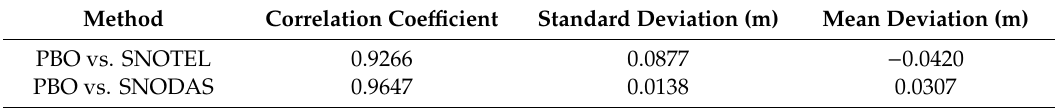
Table 3. Comparisons of snow depth estimates with di ff erent methods at p025 (on flat